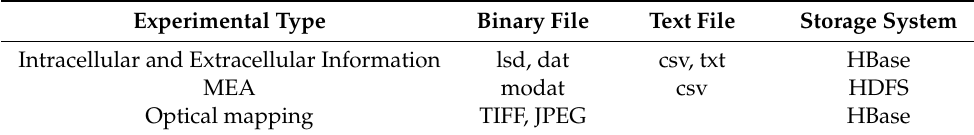
Table 4. The formats of file. MEA: multi-electrode arrays; HDFS: Hadoop distributed file